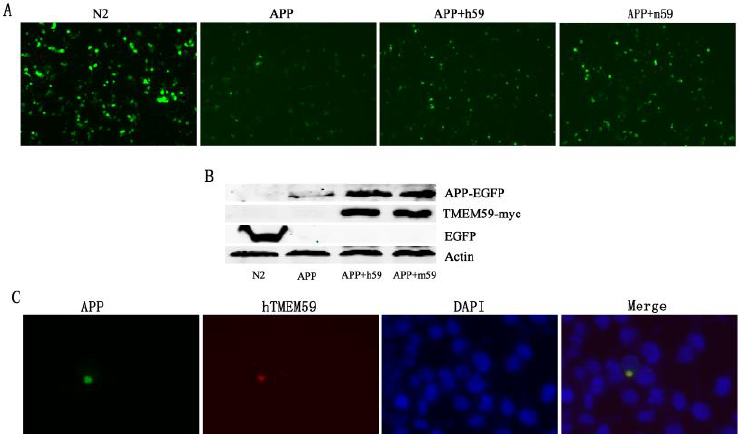
Figure 5. TMEM59 inhibits transport and increases the protein amount of APP. ( A ) Overexpression of TMEM59 leads to retention of APP in the cytoplasm. ( B ) TMEM59 increases the amount of APP protein in HEK293T cells. Western blotting showed that overexpression of TMEM59 increases the expression of APP. ( C ) TMEM59 and APP partially colocalize in the perinuclear region.